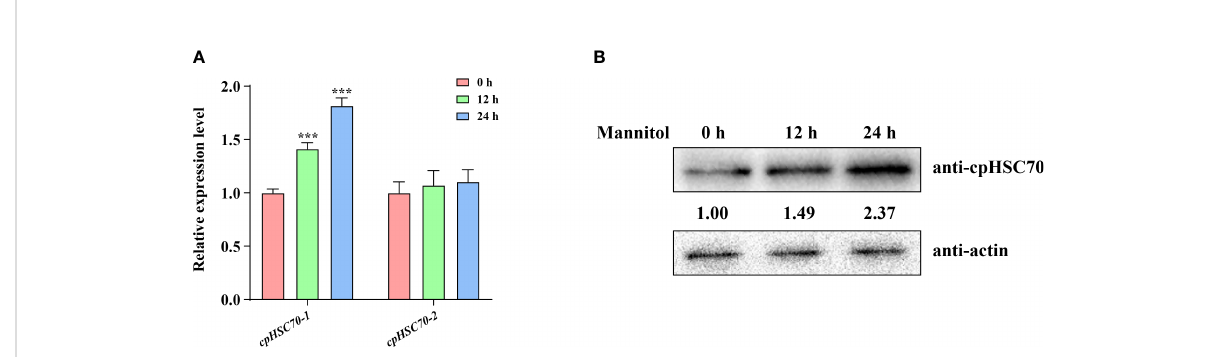
FIGURE 1 Osmotic stress induces cpHSC70-1 expression. (A) The cpHSC70-1 and cpHSC70-2 expression levels of 5-day-old wild-type seedlings subjected to osmotic stress (300 mM mannitol for 6, 12 h) and its control. The data are means ( ± SEM) from at least three independent experiments. Asterisks indicate signi fi cant differences revealed using a Student ’ s t -test (*** p < 0.001). (B) cpHSC70 protein level of 5-day-old wild-type seedlings treated with 300 mM mannitol for 0, 12, and 24 h. The intensity of each immunodetection band was measured by using an image-processing and analysis software package (ImageJ). The protein levels of 0 h were set to 1. Actin was used as